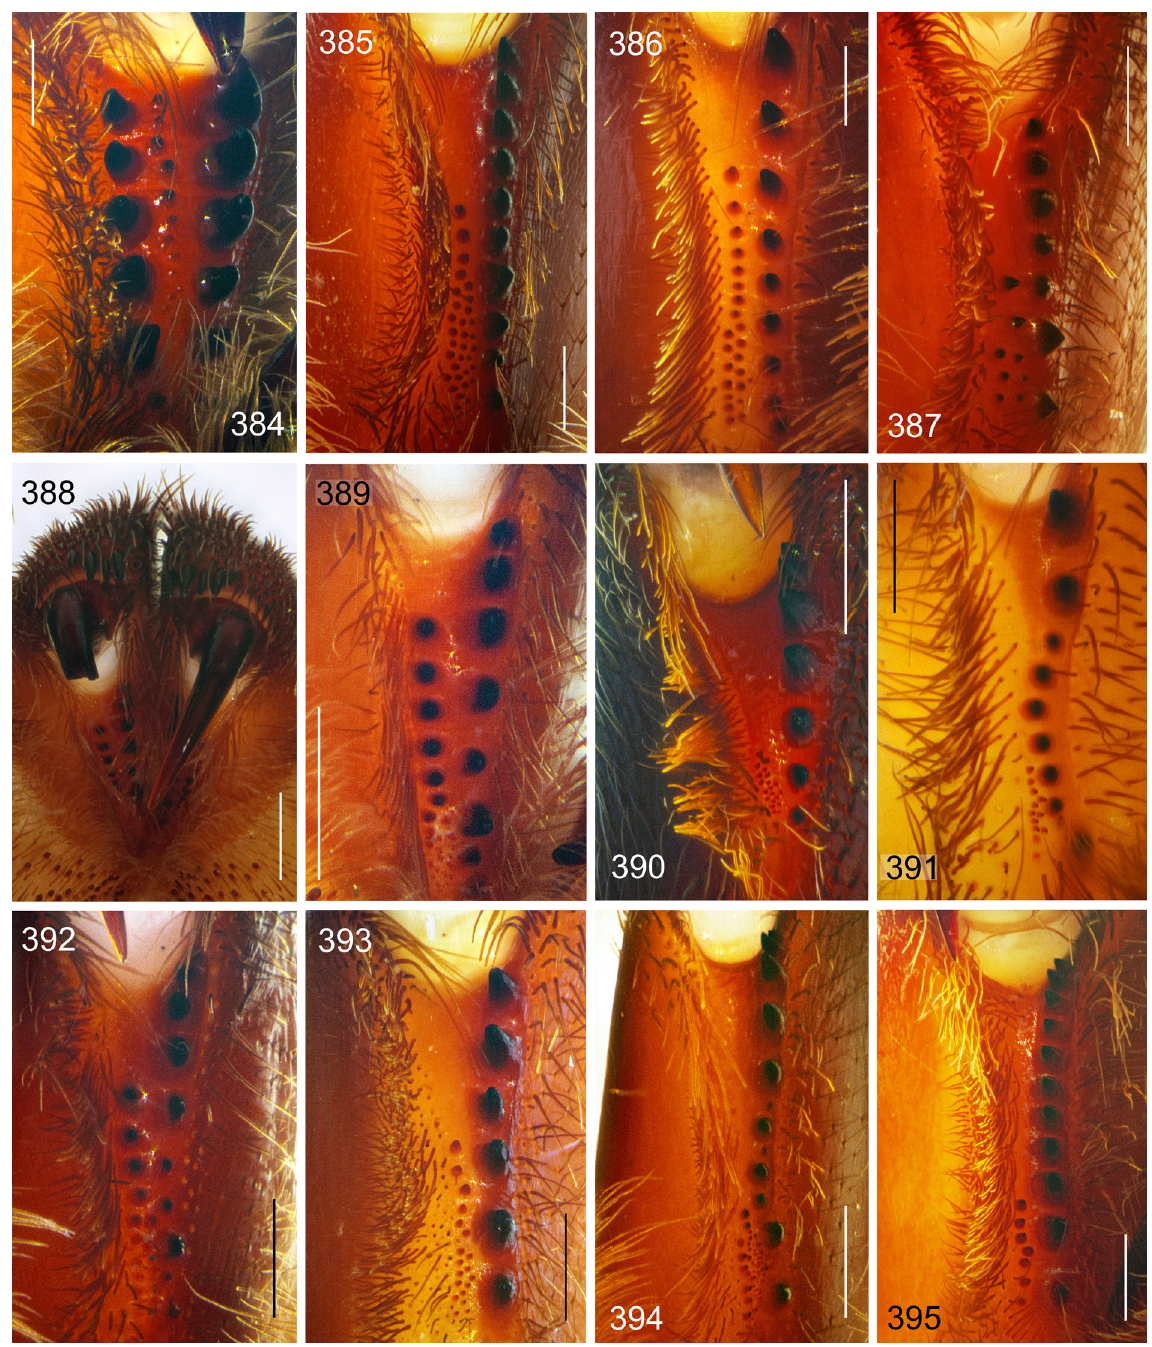
Figs 384–395. Mygalomorph spiders, members of Ctenizidae (384), Euctenizidae (385), Cyrtaucheniidae (386–391) and Nemesiidae (392–395); ♀♀ (384–386, 388–391, 393–395) and ♂♂ (387, 392); cheliceral furrow, ventral views. 3 84 . Cyrtocarenum cunicularium (Olivier, 1811). 385 . Myrmekiaphila torreya Gertsch & Wallace, 1936. 386 . Cyrtauchenius maculatus (Simon, 1889). 387 . Amblyocarenum walckenaeri (Lucas, 1846). 388–389 . Homostola zebrina Purcell, 1902. 390 . Acontius nimba Zonstein, 2018. 391 . Ancylotrypa elongata Purcell, 1908. 392 . Spiroctenus sp. 393 . Iberesia barbara (Lucas, 1946). 394 . Entypesa sp. M (undescribed species). 395 . Raveniola ferghanensis (Zonstein, 1984). Scale bars: 0.5